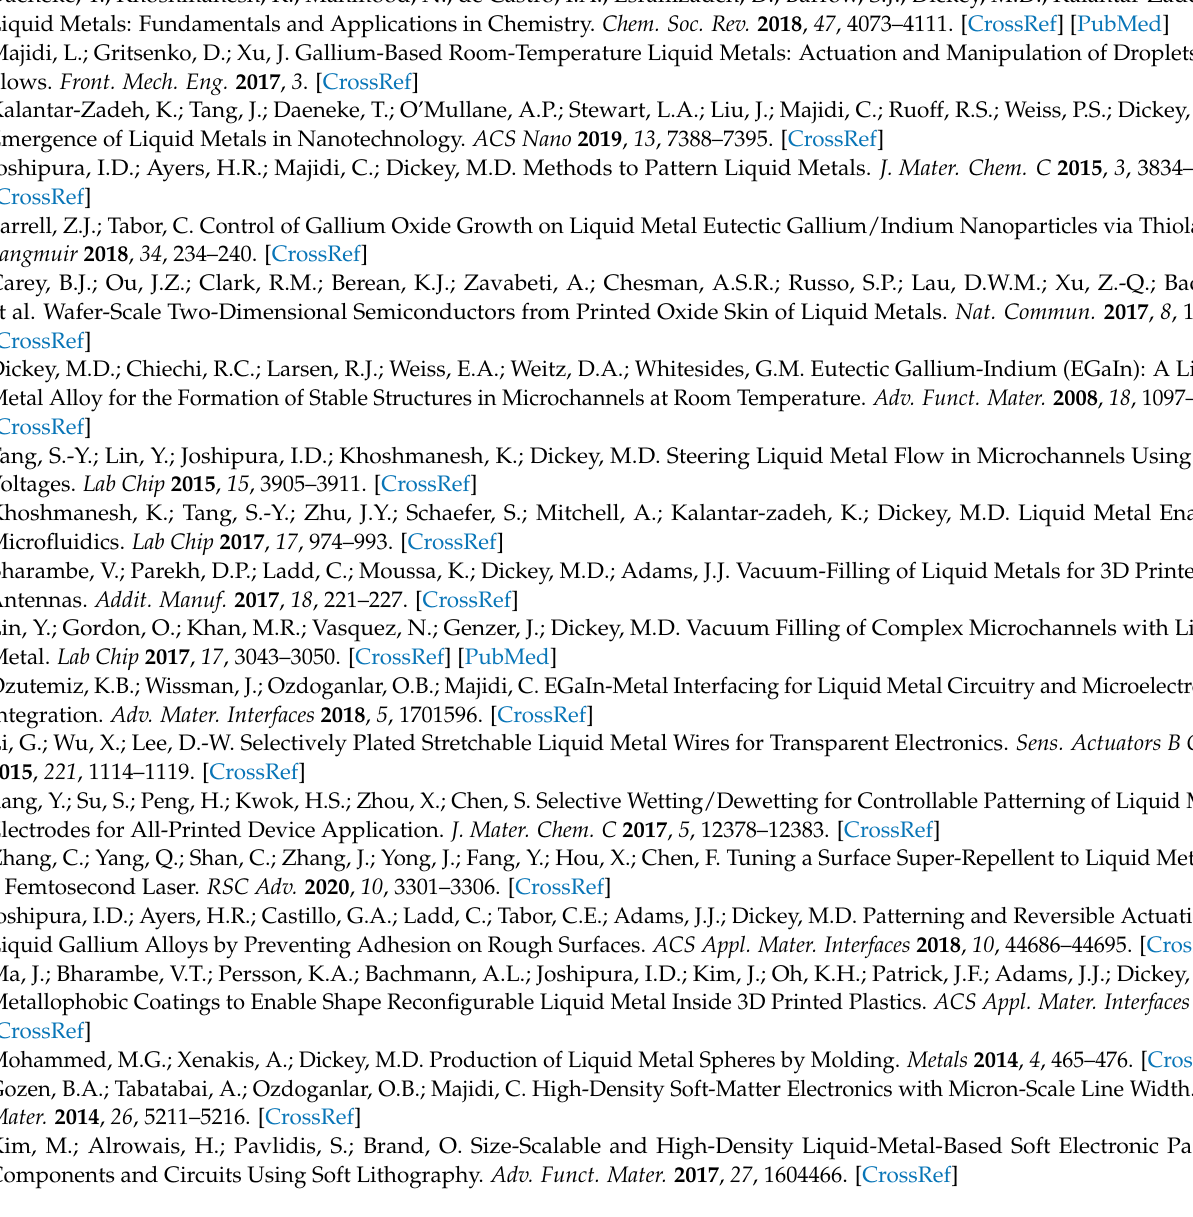
Thickness, Figure S7: Roughness of Sprayed Polymer Films, Table S1: Widths of stenciled liquid metal patterns, Table S2: Contact Resistance and Trace Resistivity, Table S3: Mean height of polymer films prepared by spraying and drop